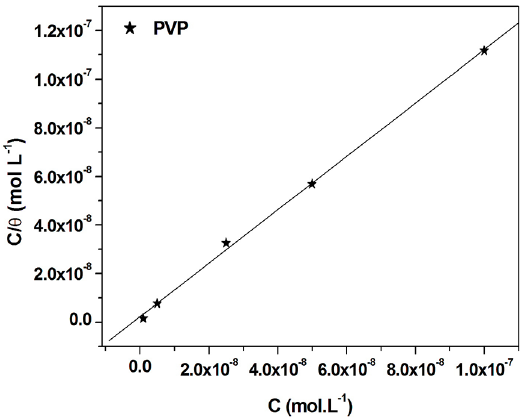
Figure 7. Langmuir isotherm plot for the adsorption of PVP on carbon steel surface in HCl 0.5 mol L -1